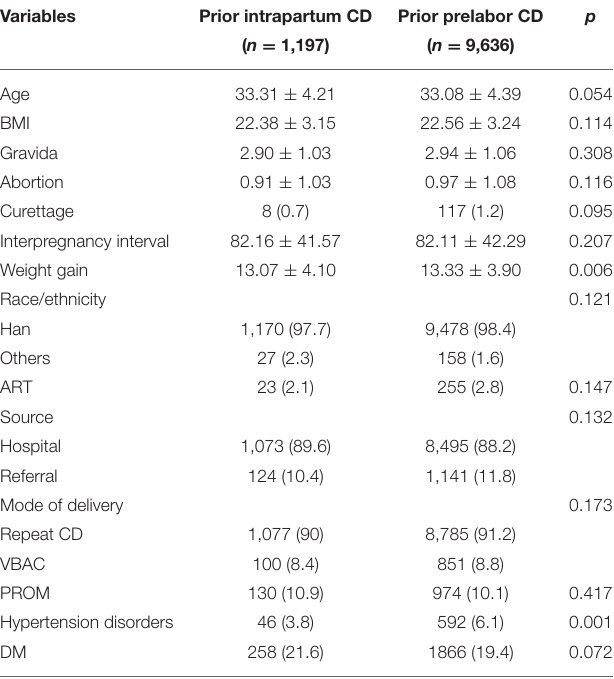
TABLE 1 | Demographics of a subsequent